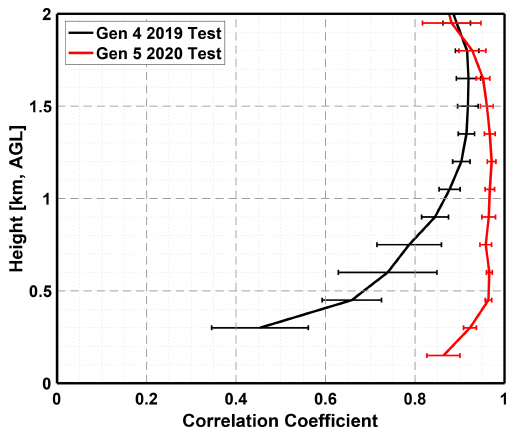
Figure 14. Correlation coefficient as a function of range for the MPD network intercomparison tests. The Gen 4 2019 test (black) occurred 5–11 April 2019 (6d) and the Gen 5 2020 test (red) oc- curred 29 September to 6 October 2020 (7d). The correlation co- efficient is calculated for 150m thick layers. The line (error bars) represents the mean (standard deviation) of the 10 intercomparison possibilities (unit 1 to 2, 1 to 3, etc.). Altitude range is capped at 2km to focus on the low-range performance. For both tests, the net- work of MPD instruments were collocated in Boulder,